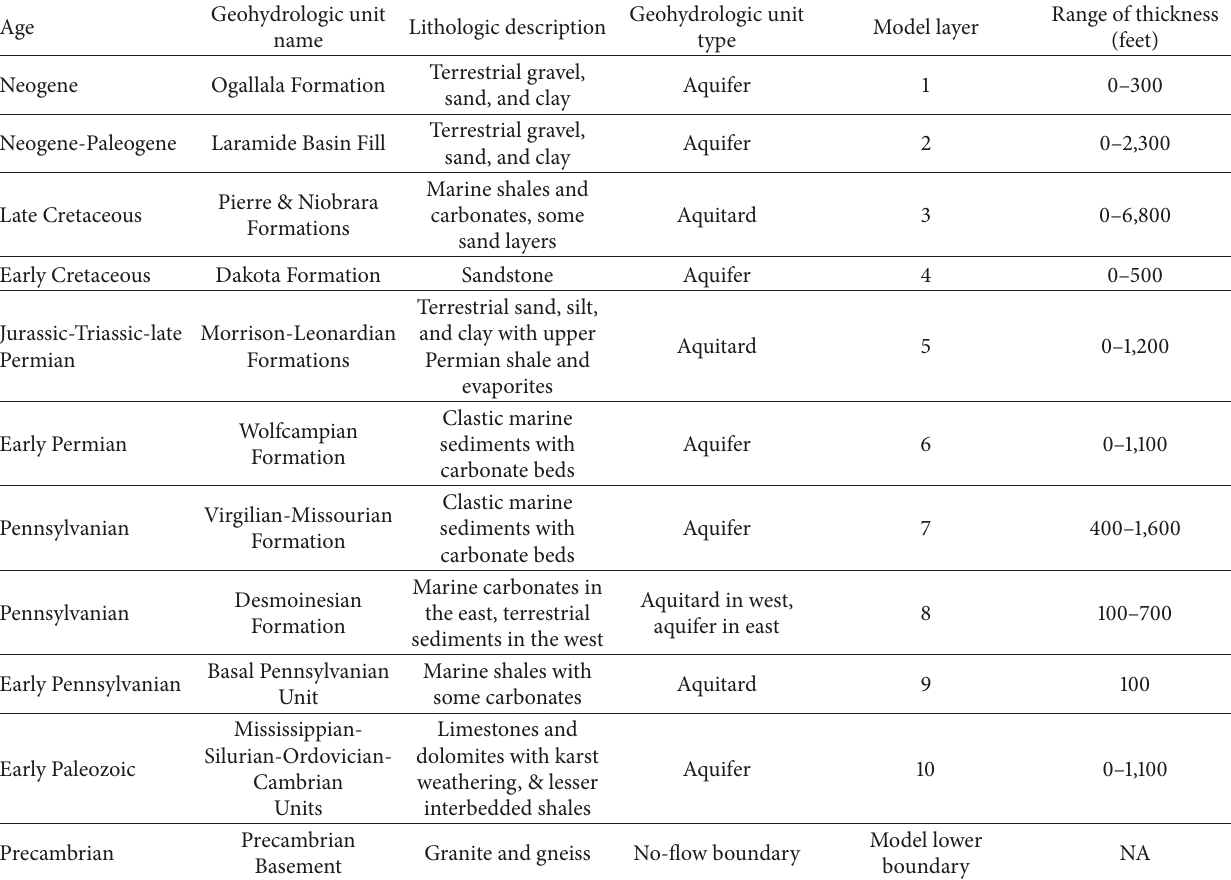
Table 2: Stratigraphic column.